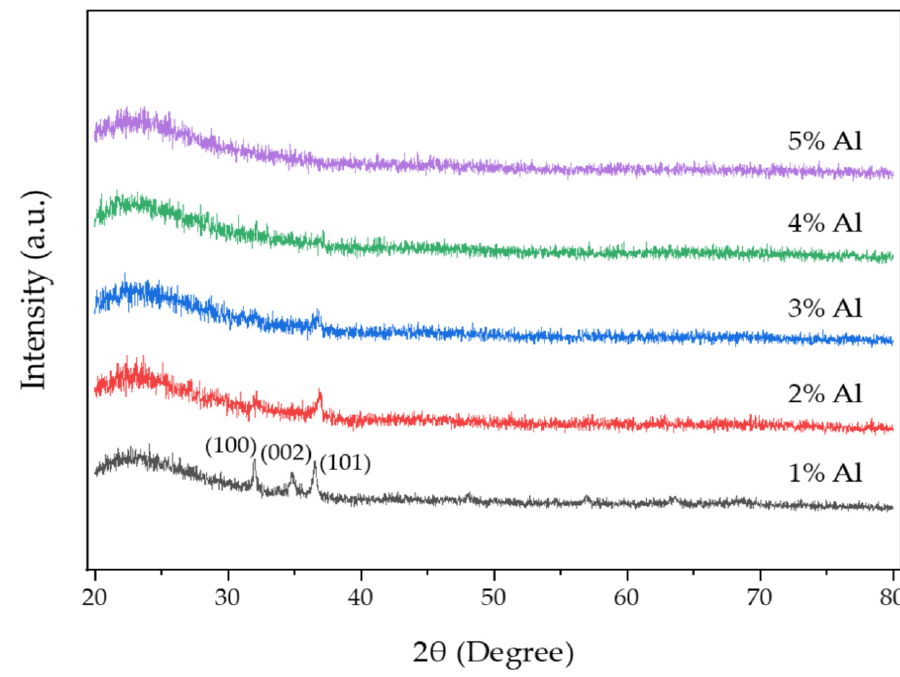
Figure 2. GIXRD patterns of AZO films with different Al ratios by the mist CVD method. Using the texture coefficient (TC) (hkl) formula [41], the preferred orientation of the (hkl) plane for AZO film could be determined. The TC values of AZO films calculated based on the XRD data from Al ratios of 1 wt % to 3 wt % are shown in Table 3. From the TC value results, it was confirmed that the TC value of (002) peak only existed at an Al doping ratio of 1 wt %. The TC value of the (100) peak was significantly reduced when the Al ratio was increased from 1 wt % to 3 wt %. Compared to the TC value of (002) and (100) orientations, the TC value of (101) peak was the dominated orientation for all three kinds of AZO films, which meant that the preferred growth of AZO films was (101) crystal plane. Table 3. Texture coefficient values of AZO films deposited with different Al ratios. Al Doping Ratio (wt